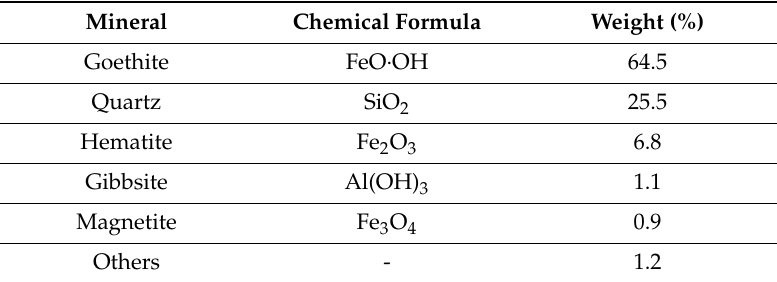
Table 3. Mineralogical composition of the amphibolitic itabirite